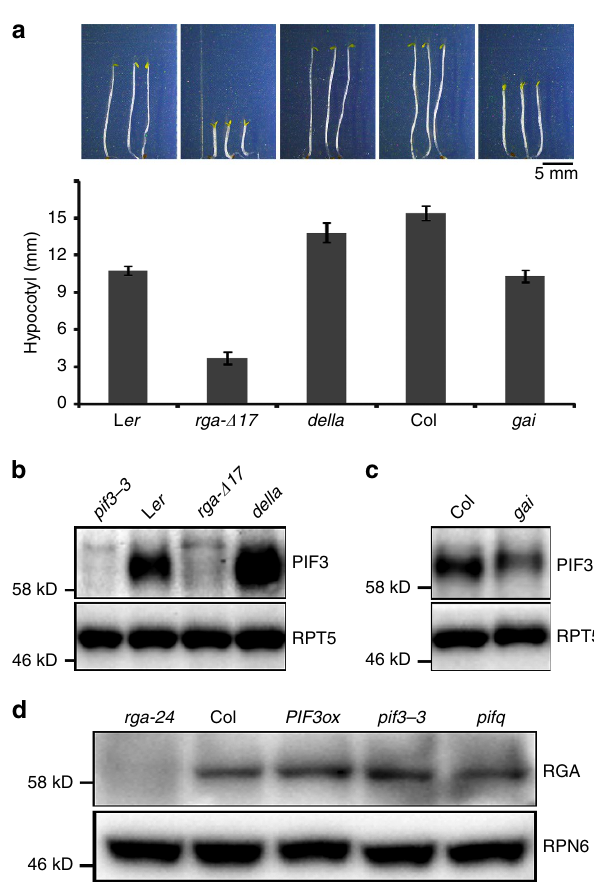
Figure 1 | DELLAs negatively regulate PIF3 protein abundance in the dark. ( a ) Phenotypes and hypocotyl lengths of 4-day-old dark-grown rga- D 17 , della , gai and their wild-type counterparts. Means ± s.d. were obtained from at least 30 seedlings. ( b , c ) Endogenous PIF3 protein levels in various DELLA mutants. Total proteins extracted from 4-day-old dark- grown seedlings were immunoblotted with anti-PIF3 and anti-RPT5 antibodies. RPT5 was used as a loading control. ( d ) Effects of PIFs on RGA protein levels. Four-day-old dark-grown seedlings were collected for protein extraction, and total proteins were immunoblotted with anti-RGA and anti-RPN6 antibodies. PIF3ox indicates 35S:PIF3-Myc . RPN6 was used as a loading control. Each immunoblot result is the representative of at least three dramatically reduced (Fig. 2e). Similarly, the accumulation of GAI D 17-HA after 24 h DEX treatment also led to the reduction of PIF3 protein (Fig. 2f). There were no obvious changes of PIF3 transcripts during the DEX induction (Supplementary Fig. 1c,d), indicating that DELLAs negatively regulated PIF3 mainly at the protein level.